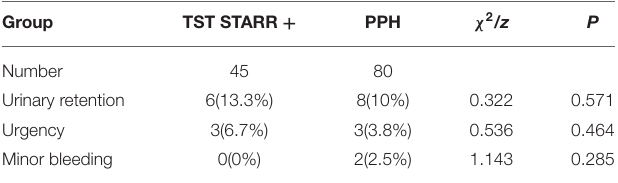
TABLE 2 | Safety assessment at 1 month.